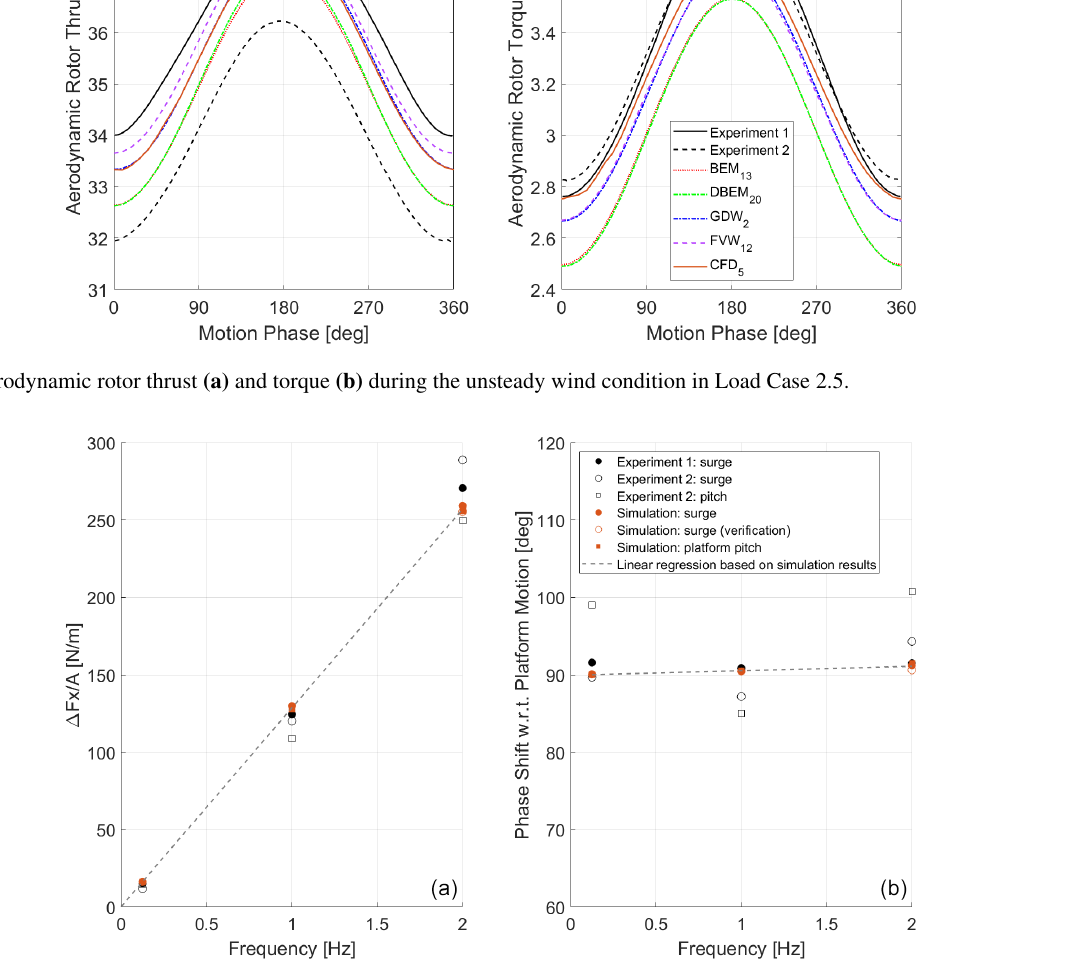
Figure 17. Normalized aerodynamic rotor thrust variation (a) and phase shift with regard to platform motion (b) during unsteady wind conditions using load cases from 2.1 to 3.7 (excluding Load Cases 2.16 and